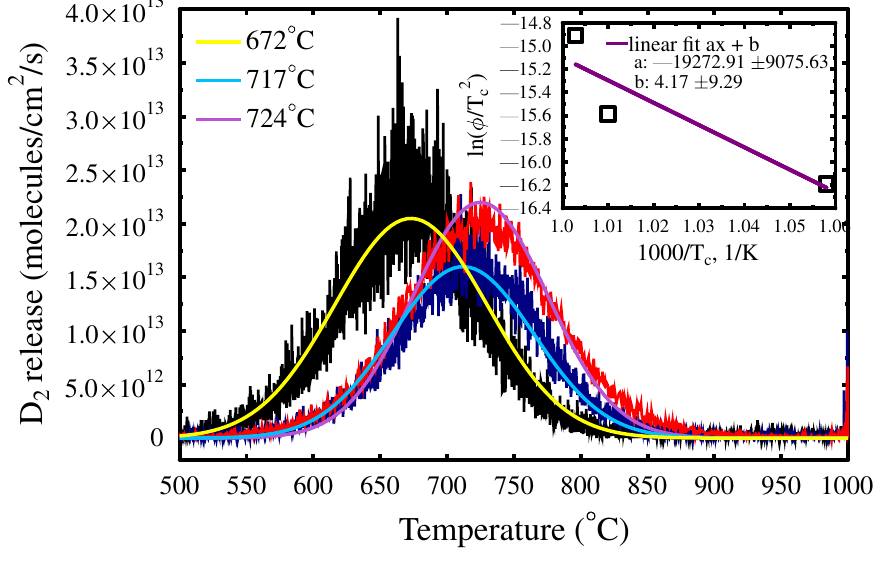
Figure 3. The three thermal desorption measurements from the WMoTaNbV alloy with heating rates of 5, 10, and 20 ◦ C per minute. The D release peak positions correspond to the trapping energy of 1.66 ± 0.78